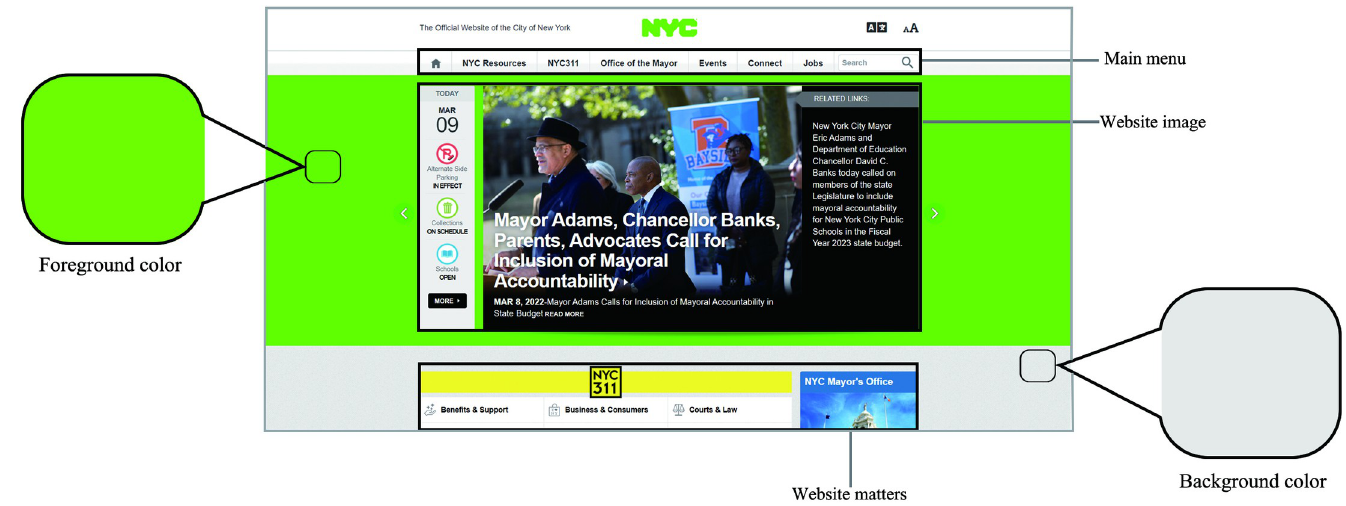
Fig 1. Color extraction of multimedia